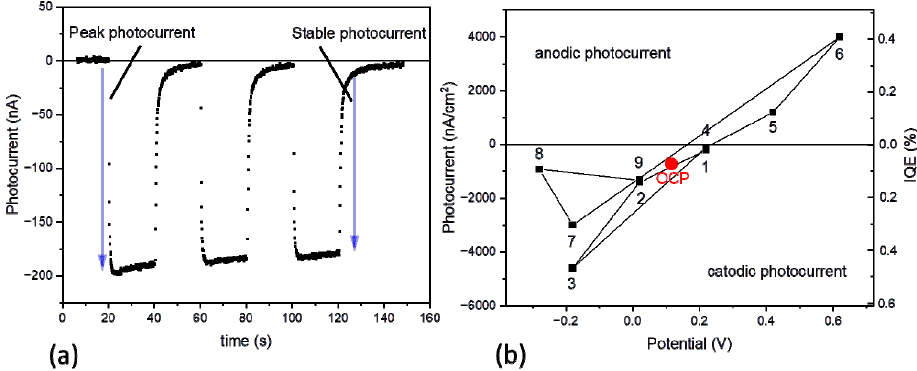
Figure 4. Photocurrent generated in the PSI-FTO electrode with ~40 layers of PSI complexes. ( a ) Chronoamperometric data recorded for the PSI-FTO electrode of the photoactive surface of ~0.25 cm 2 at OCP (see corresponding red circle in panel b); three cycles of light illumination are presented with peak and stable photocurrents indicated; ( b ) stable photocurrent amplitudes (left axis) and corresponding IQE (right axis) vs. potential applied to WE (dark current baseline has been subtracted from the original chronoamperometric data); the numbers at the experimental points show the sequence of the applied potentials; additionally, photocurrent measured at OCP is shown (red circle). Note that, in panel b, photocurrent was recalculated per centimeter squared.